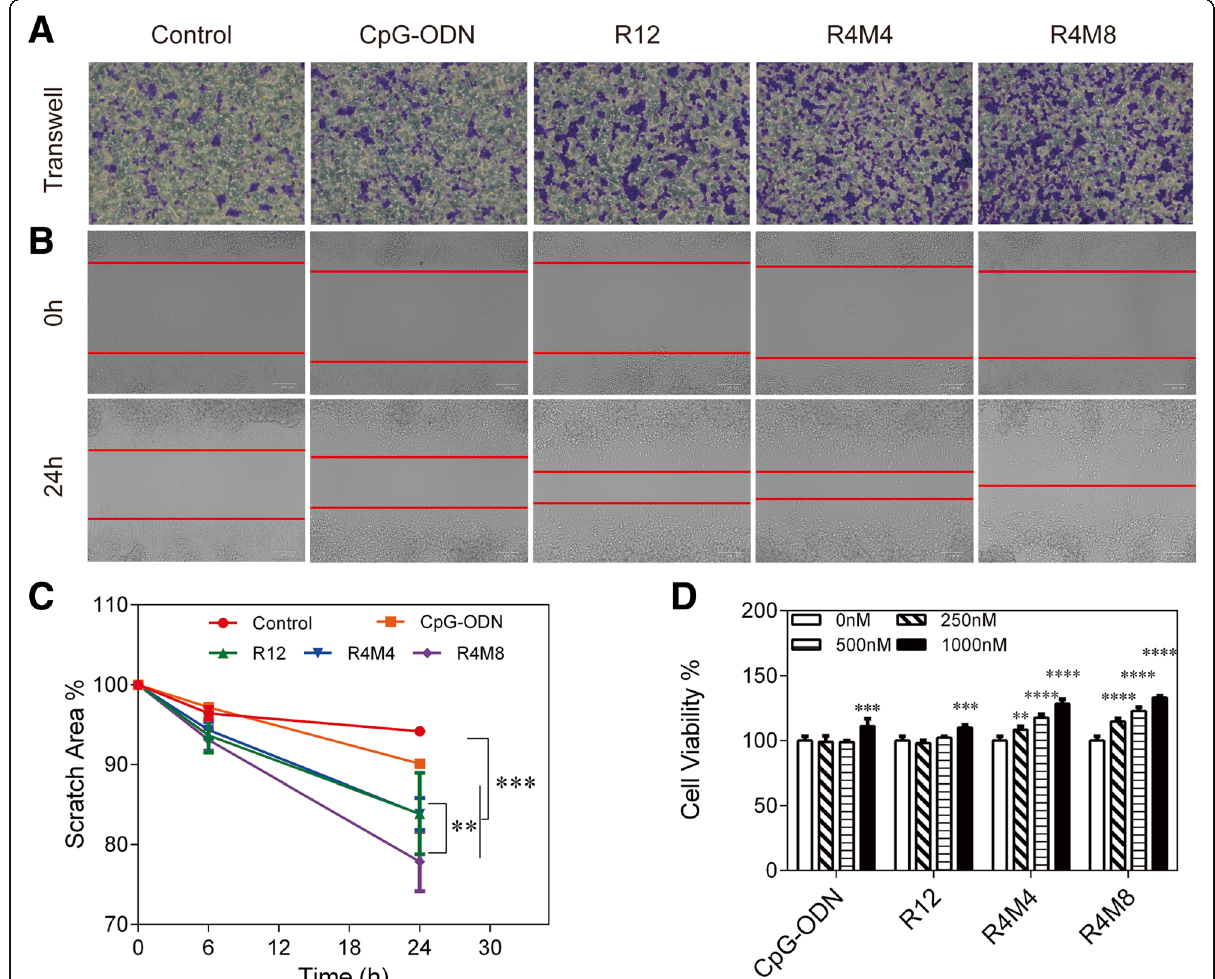
Fig. 4 The analysises of migration and cell viability of CpG-ODN, CpG-RCA gel (R12), and CpG-MCA gels (R4M4 and R4M8) in RAW264.7 cells. a The migration assay of RAW264.7 cells induced with CpG-ODN, R12, R4M4, and R4M8. b The migration assay of RAW264.7 cells stimulated with CpG-ODN, R12, R4M4, and R4M8 for 24h. c The scratch area analysis in the scratch migration experiment. The percentages are calculated as the ratio of the original area. d The cell viability of RAW264.7 cells treated with CpG-ODN, R12, R4M4, and R4M8 for 24 h. Results are expressed as the mean±SD of three independent experiments. ** P <0.01, *** P <0.001, **** P